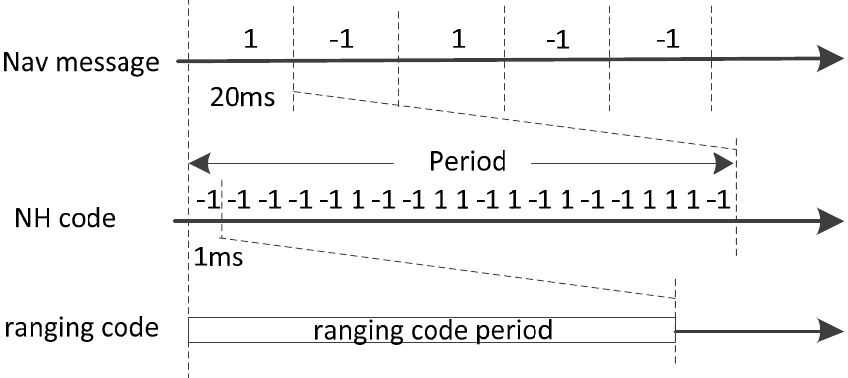
Figure 1. Signal structure of B1I and B2I signal broadcasted by MEO/IGSO and GEO satellites.